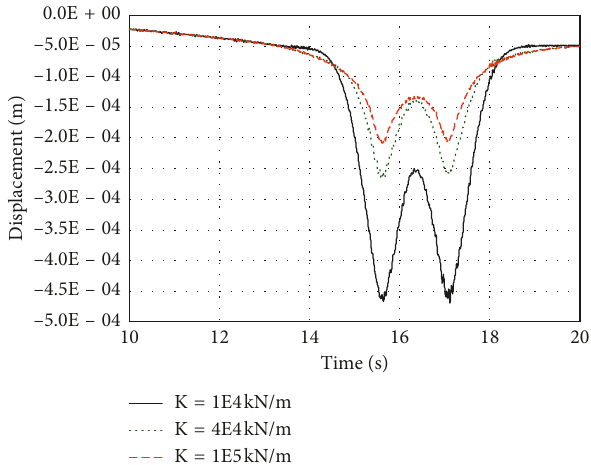
Figure 11: Displacement of a point at the rail induced by the moving crane under three different rail pad stiffness